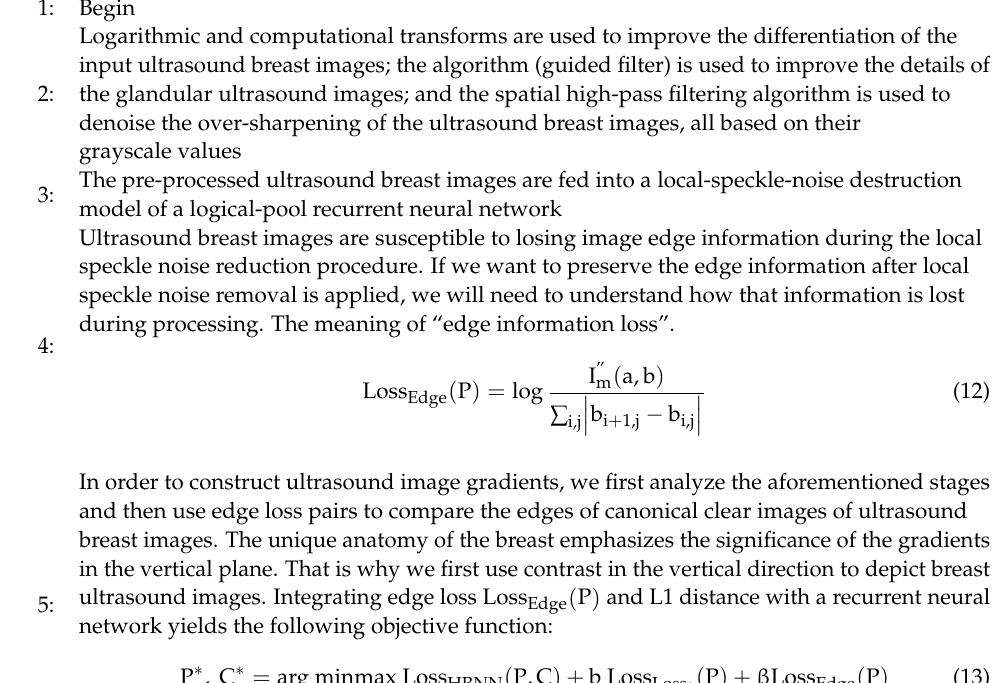
Algorithm 1. Noise removal of the local speckle